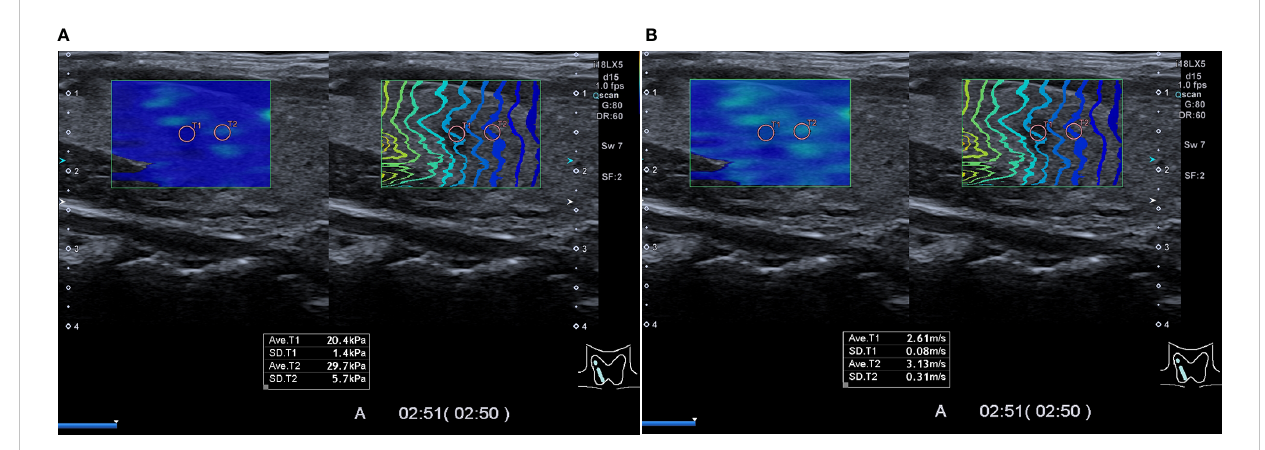
FIGURE 3 Preoperative shear wave elasticity images. Preoperative shear wave elasticity image of a patient with papillary thyroid cancer in the right lobe of the thyroid. Results of two types of shear wave elasticity measurement are shown in (A, B) as kPa and m/s, respectively. The region of interest was placed on the tumor (T1) and the surrounding thyroid parenchyma (T2), respectively, in the green sampling box. On the left, the color indicates the hardness of the tissue, and on the right, the contour lines depict shear wave arrival times at different